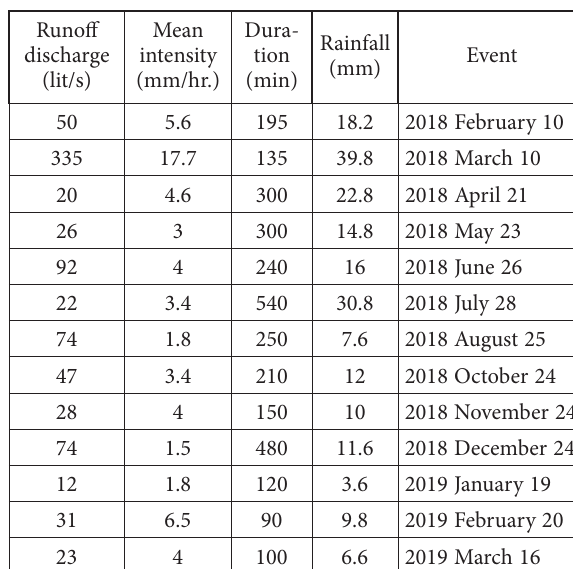
Table 1. Stormwater runoff monitoring for rainfall events in